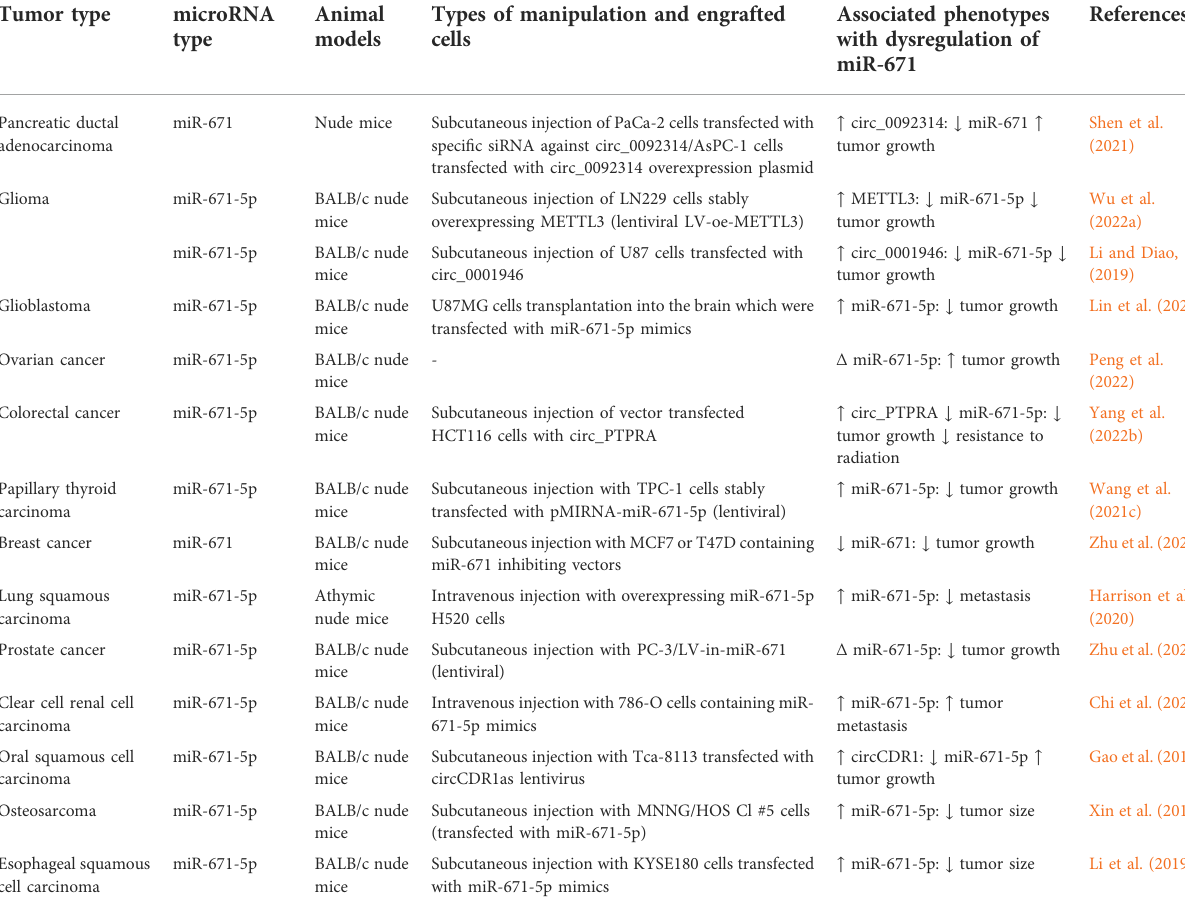
TABLE 2 Effect of miR-671 in cancer development based on research in animal models. ( Δ : knockdown or